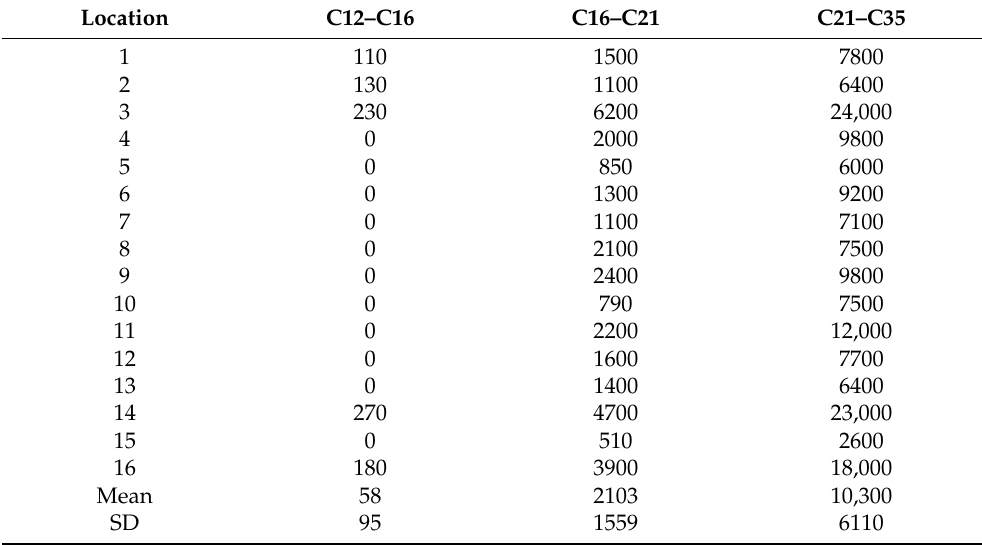
Table 2. Concentrations (mg/kg) of aromatic hydrocarbons in the oily sludge samples collected from the oilfield waste pit.